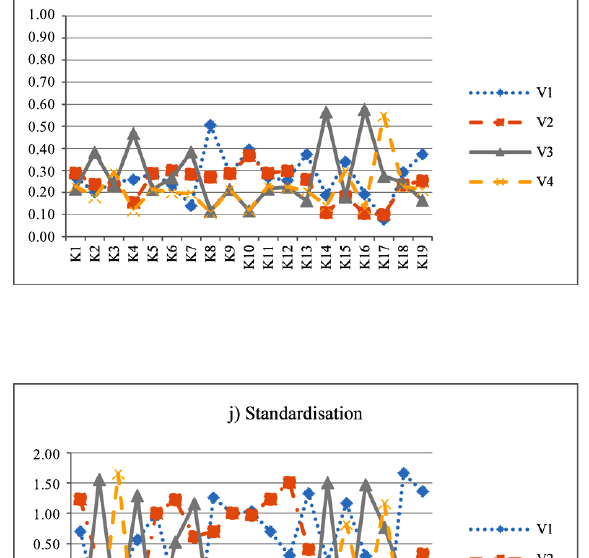
Table 3. Distribution of weights according to the equal weights approach No. Criteria Weights TRANSPORT 0.25 Length of